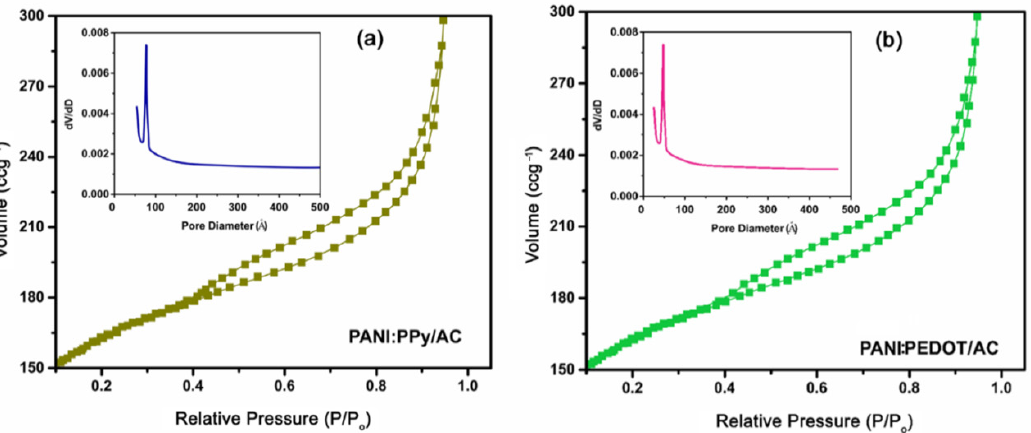
Figure 4. Isotherm of nitrogen adsorption–desorption recorded for ( a ) PANI:PPy/AC and ( b ) PANI:PEDOT/AC composite.